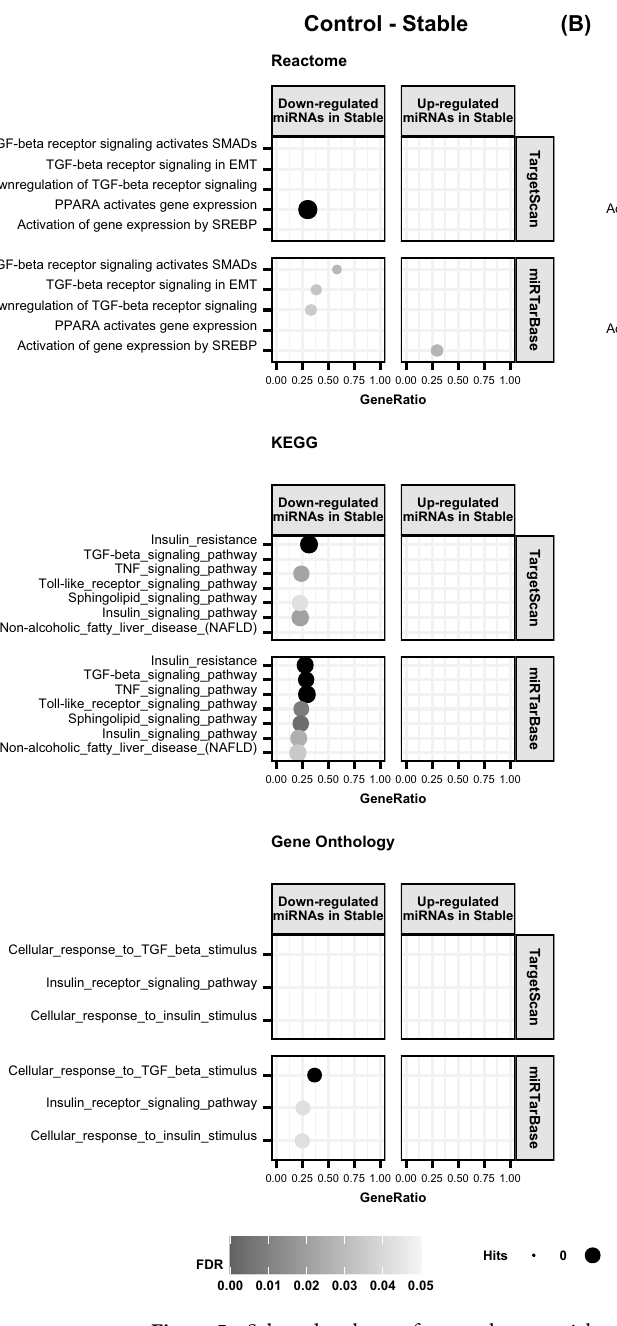
Figure 5. Selected pathways from pathway enrichment analysis of predicted miRNA targets. ( A ) Analysis of miRNAs either down- or up-regulated in the stable CAD patients compared to the controls. ( B ) Analysis of miRNAs either down- or up-regulated in the stable CAD patients compared to the acute CAD patients. Analysis was carried out either with the targets predicted by TarPmiR and computational algorithm by TargetScan or TarPmiR and experimentally validated target database miRTarBase. Only pathways that were statistically significant (FDR < 0.5) and pathways with gene ratio > 0.2 are presented. Bubble size represents the amount of hits within the pathway from the predicted target genes. Gene ratio represents the ratio of the predicted targets within a pathway and all genes in that